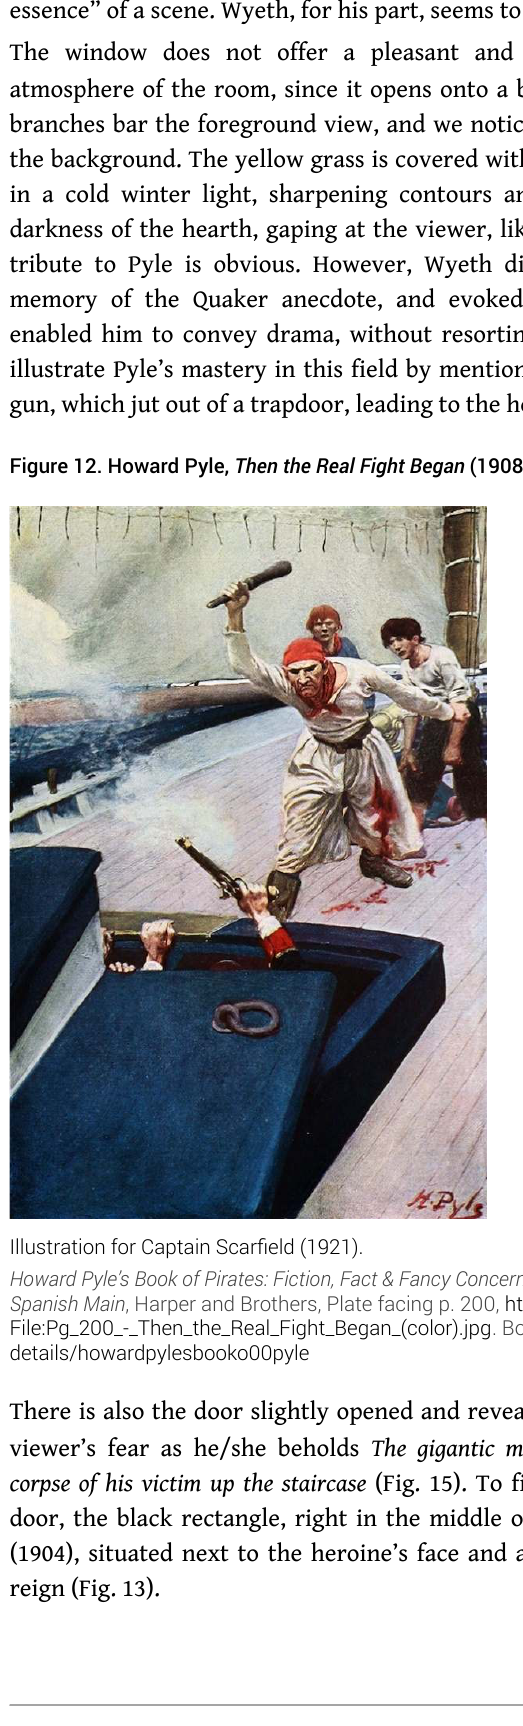
Figure 12. Howard Pyle, Then the Real Fight Began (1908)